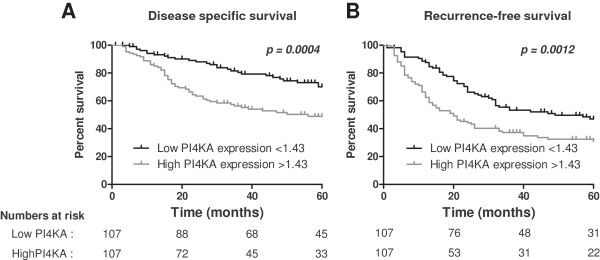
Mantel-Cox survival curves. The Kaplan Meier method and Log-Rank test were applied to data for 214 patients with HCC classified into two groups according to whether the PI4KA expression value was above or below the median (low- or high-amount of PI4KA mRNA). A and B panels present disease-specific survival (tumor-related death) and tumor recurrence-free survival, respectively. P values are indicated. Numbers at risk are indicated below each panel.